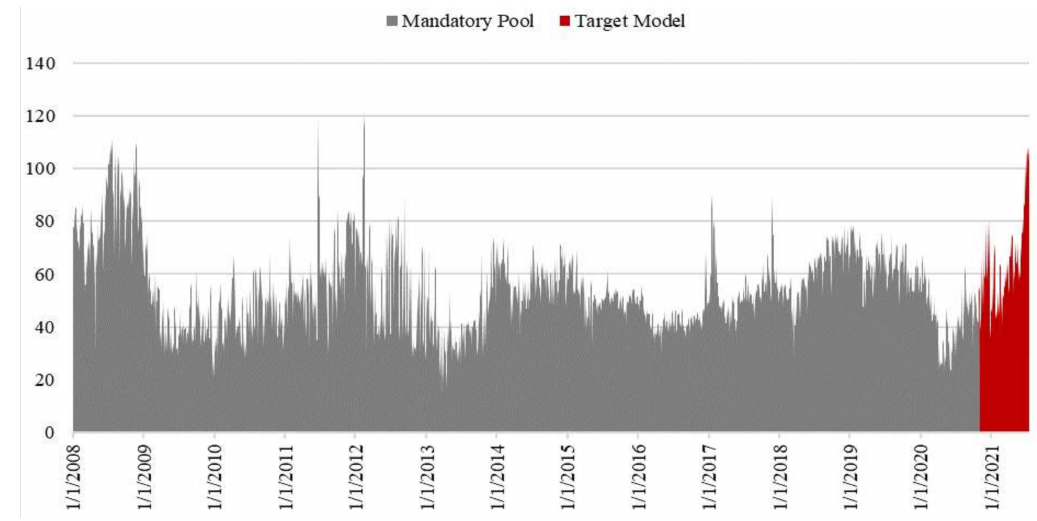
Figure 11. Daily Average Market Clearing Price in Greece ( € /MWh), (2008–July 2021), Source: Hellenic Energy Exchange and Authors’